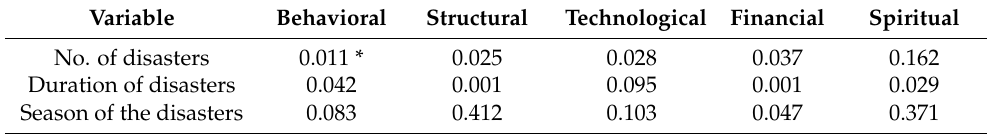
Table 3. Statistical relationship between disaster characteristics and coping strategy selection. Variable Behavioral Structural Technological Financial Spiritual No. of disasters 0.011 * Duration of disasters